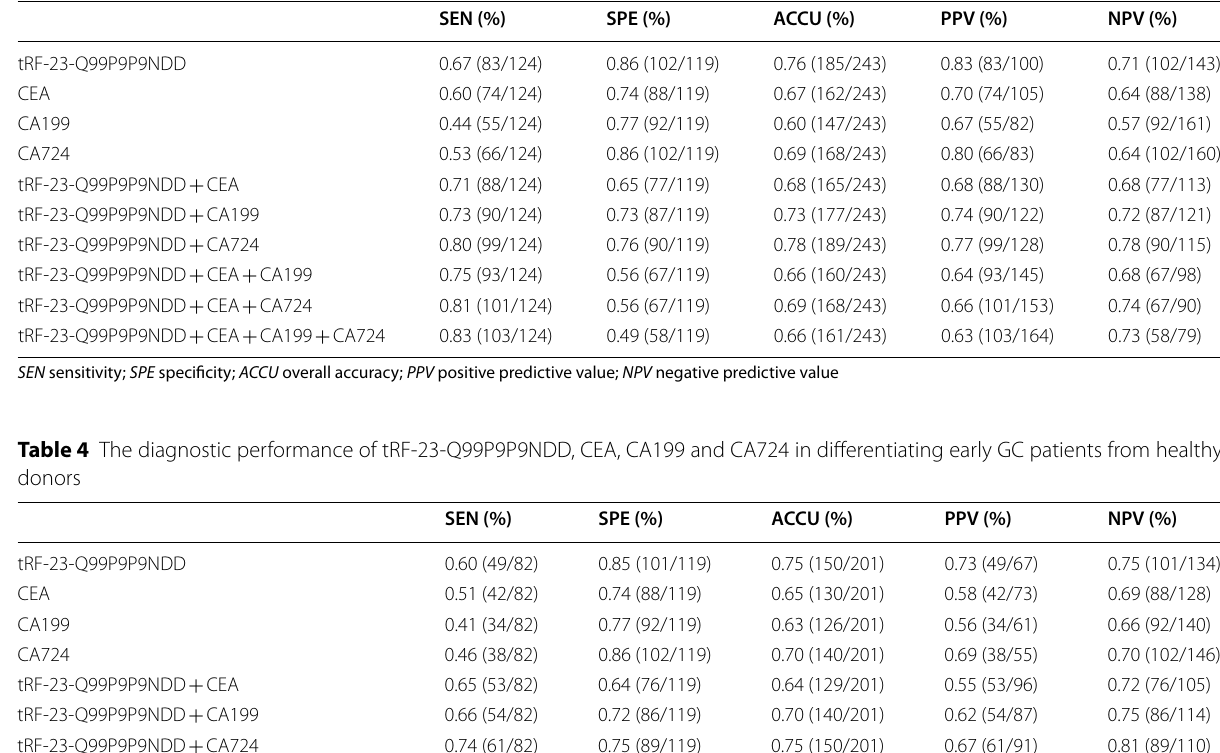
Table 3 The diagnostic performance of tRF-23-Q99P9P9NDD, CEA, CA199 and CA724 in differentiating GC patients from healthy donors